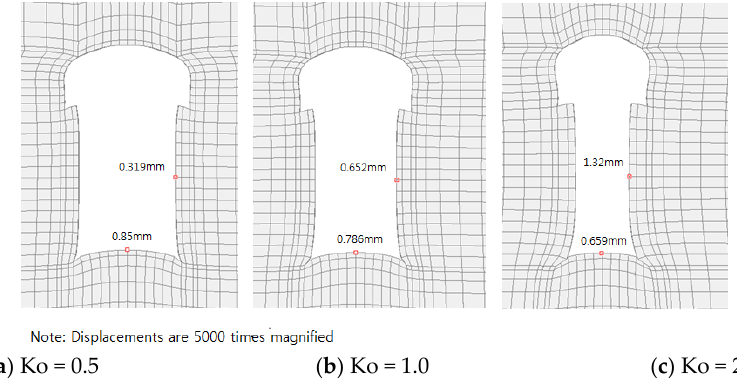
Figure 11 . Deformed shapes of the underground silo . Figure 11. Deformed shapes of the underground silo. Table 4. Displacements at key locations obtained through 2D analysis (unit: mm).